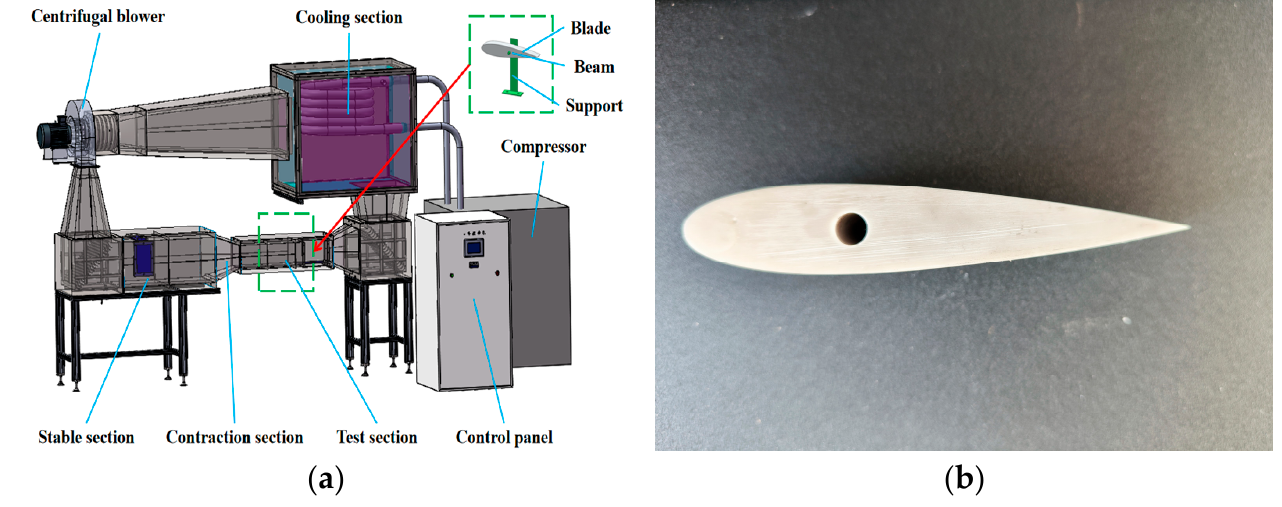
Figure 1. Schematic diagram of ( a ) icing wind tunnel test system and ( b ) test blade model.